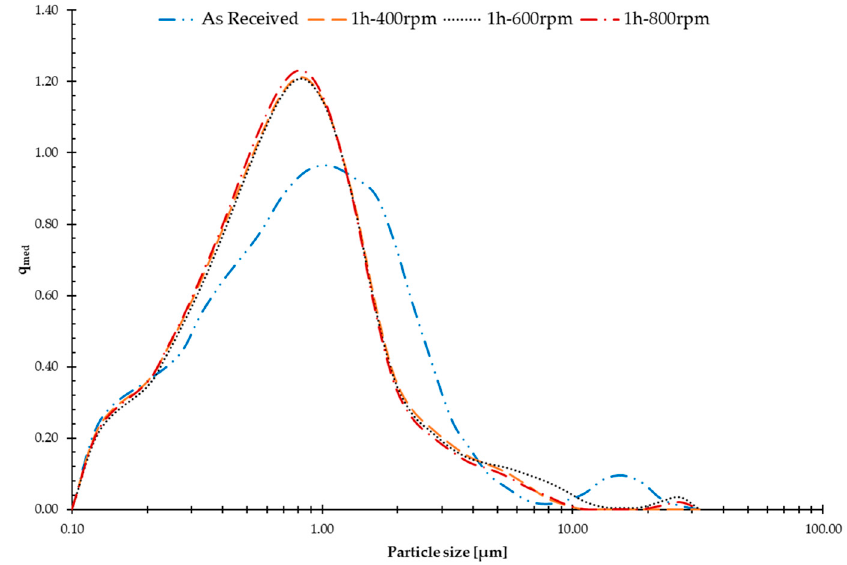
Figure 3. Particle size distribution of the as-received and the most successful BMed powders.